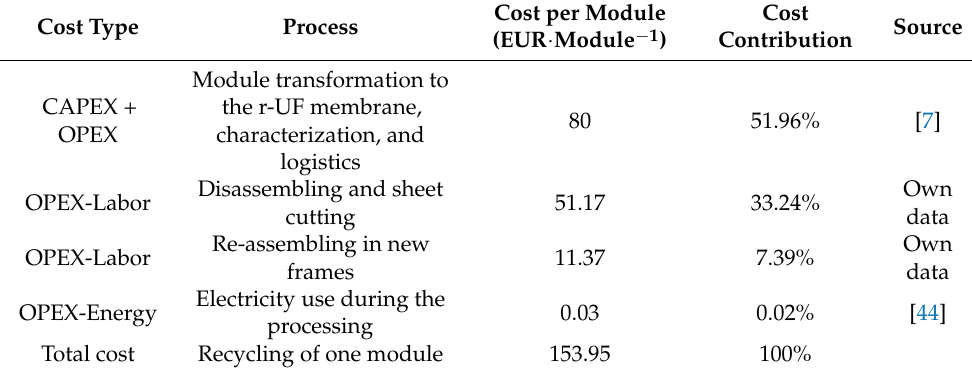
Table 6. Cost contribution analysis of the different processes for r-UF membrane preparation.